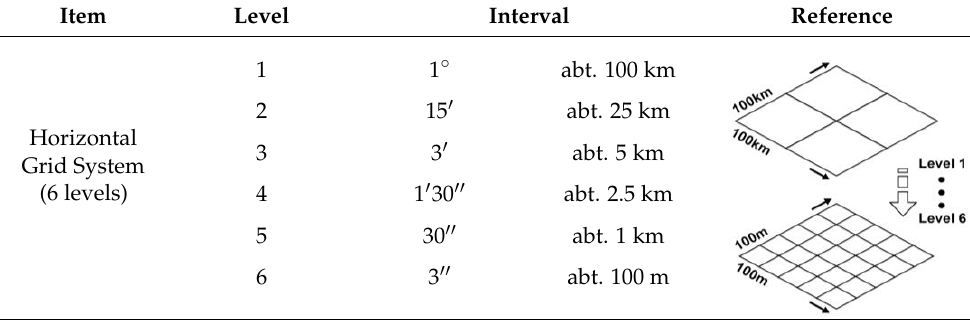
Table 3. Size of the Korea Hydrographic and Oceanographic Agency by grid level.